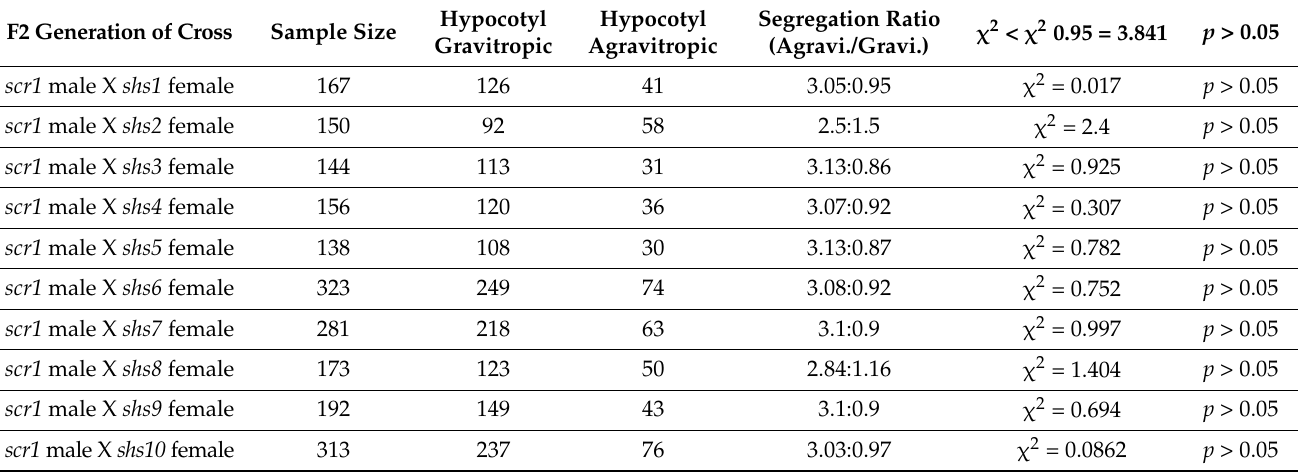
Table 1. Backcross of A. thaliana scr hypocotyl gravitropic suppressors with scr1 . F2 generation progenies of scr1 X shs suppressors were analyzed to test the hypocotyl agravitropic/gravitropic ratio. χ 2 < 3.84 is nonsignificant at 0.05 probability level.